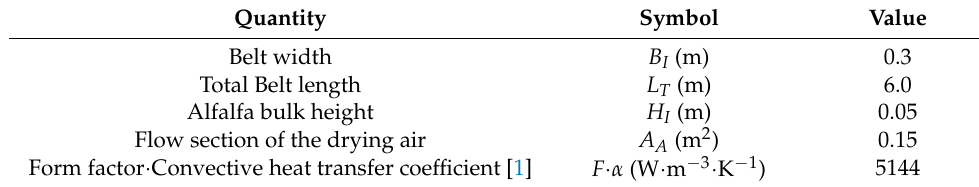
Table 1. Geometrical and operational data of the pilot